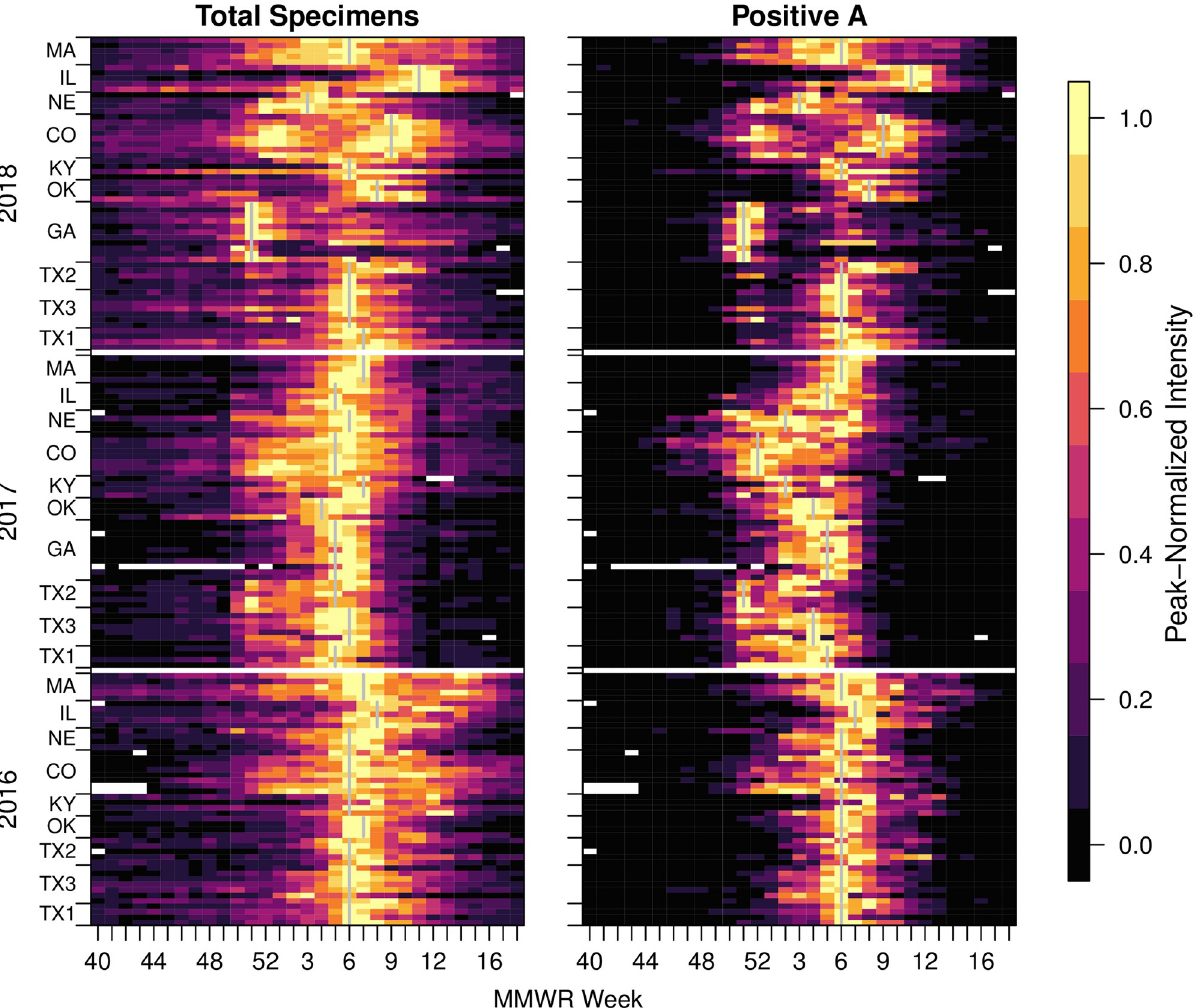
Fig 2. Incidence for each cluster for syndromic (total specimens, LHS) and specimens positive for A (RHS). Each row of rectangles represents a single county with counties grouped into clusters (bounded by tick marks) and then into seasons. Seasons are indicated by start year on the y-axis (with a blank row between years). Within seasons, clusters are ordered by latitude and within clusters, counties are also ordered by latitude. Cluster peak weeks are marked with a gray vertical line. In this figure, the incidence for each week is normalized for each county and year using the peak value for that year (Legend, RHS). White indicates ‘no